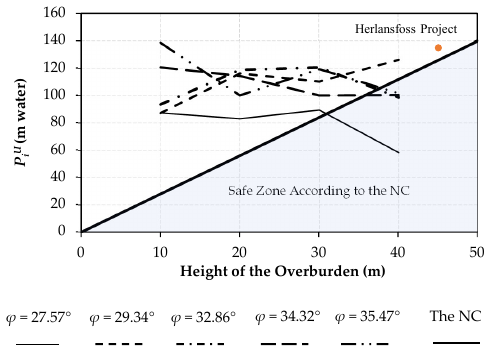
Figure 10. Comparing P iU based on the finite element model (FEM) results, the Norwegian design criterion (NC), and an actual pressure tunnel project, under steady-state conditions.